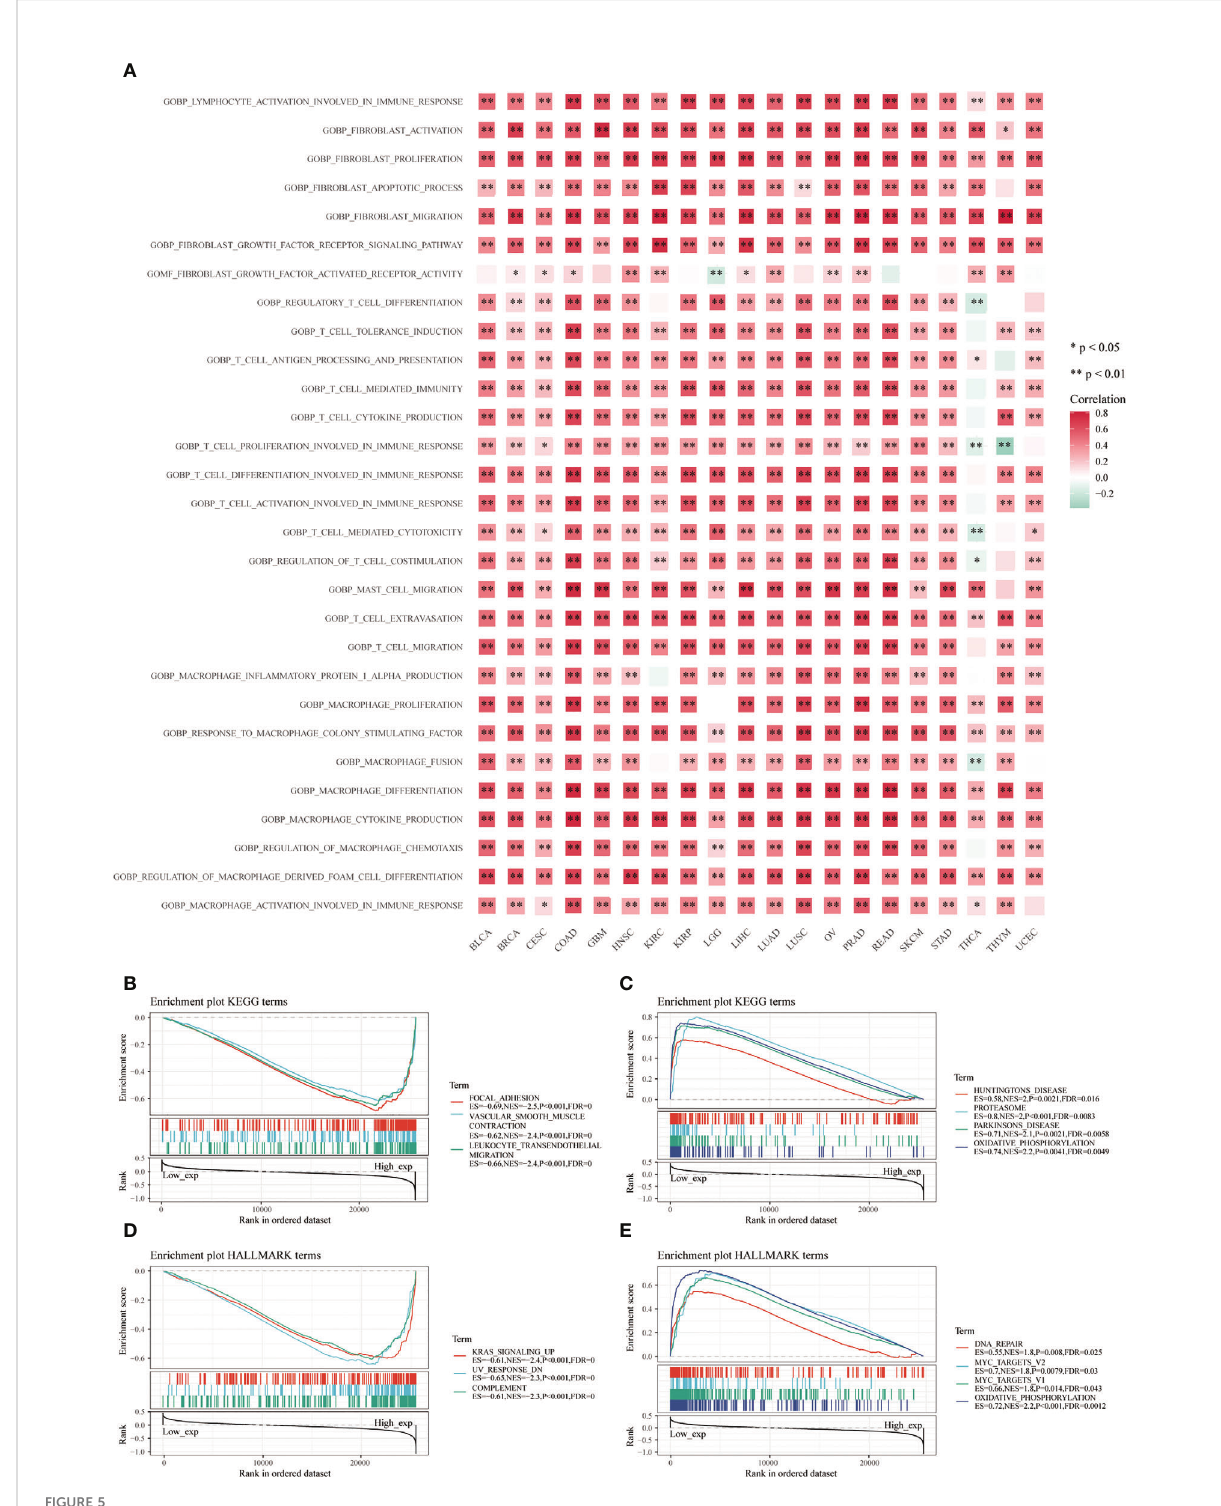
FIGURE 5 Functional analysis based on CD93 expression. Correlation analysis of CD93 from the GSVA algorithm (A) . Top three negative (B) and top four positive (C) enriched pathways using the KEGG database. The top three negative (D) and four positive (E) enriched pathways using the HALLMARK